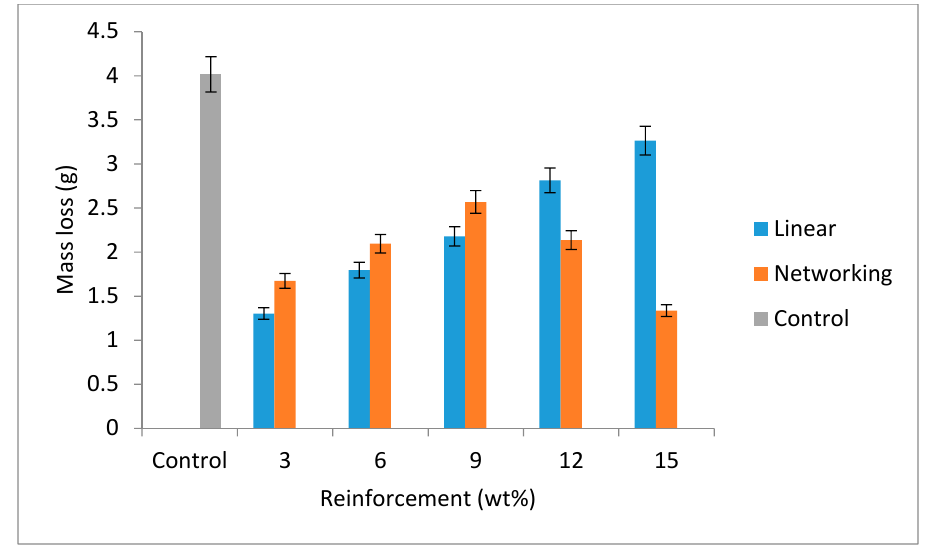
Figure 6. Variation of mass loss with wt% of reinforcement for the composites and the control